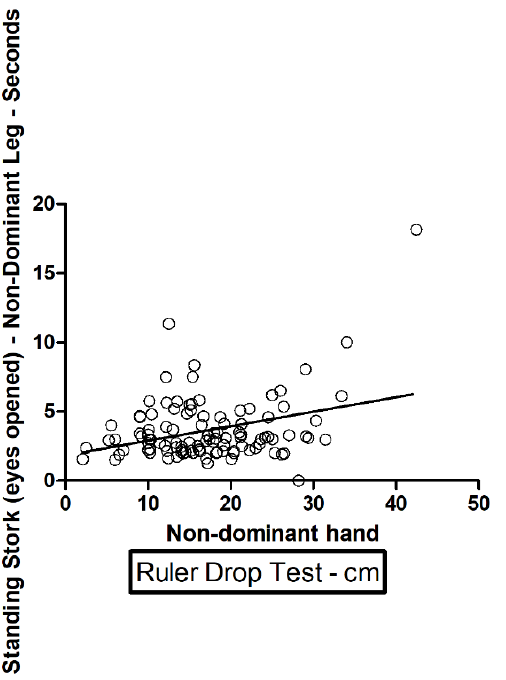
Figure 2. Standing stork (eyes opened) nondominant leg and nondominant